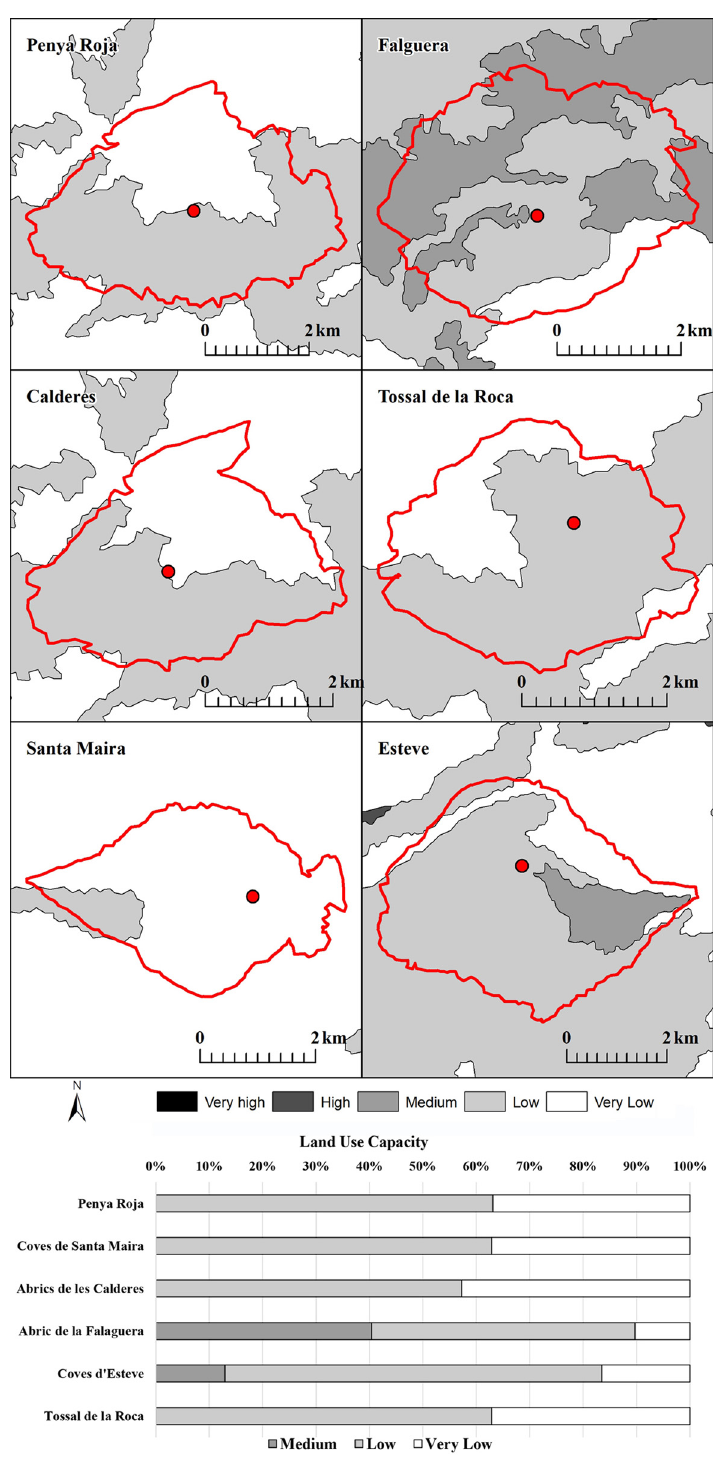
Figure 7: Site catchment analysis and land use